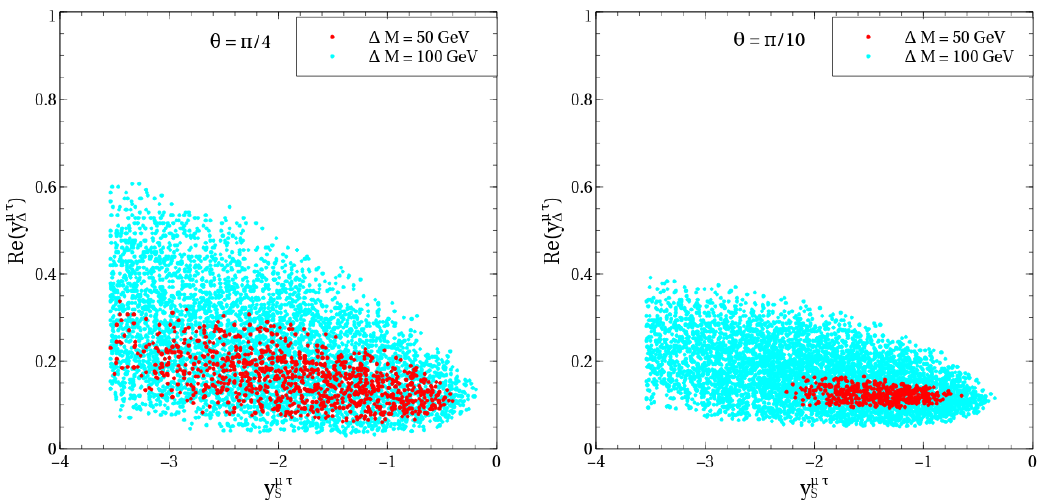
Figure 9 . The allowed parameter space maintaining (cid:1) a (cid:22) within its 2 (cid:27) range and BR (cid:28) ! (cid:22) (cid:22)ee within the quoted limit in the y (cid:22)(cid:28) mass hierarchy is assumed. The color coding is explained in the